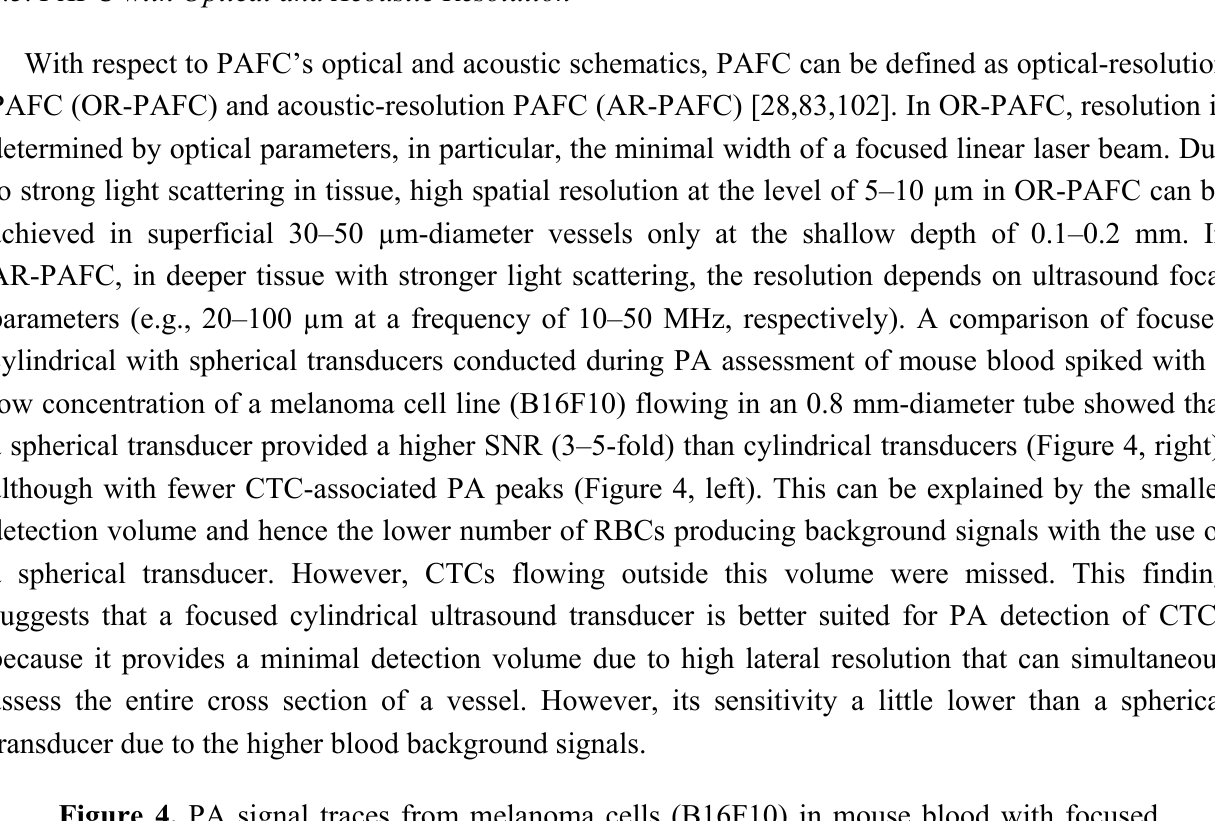
Figure 4. PA signal traces from melanoma cells (B16F10) in mouse blood with focused spherical (left) and cylindrical (right) ultrasound transducers with focal lengths of 6 mm and lateral resolution of ~60 µm. These data were obtained by Y.